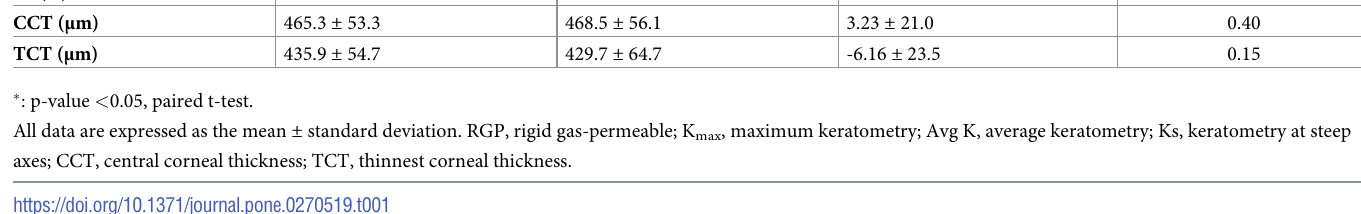
Table 2. Changes in keratoconus progression indices of the anterior and posterior corneal surface before and after the use of a rigid gas-permeable contact lens. Anterior surface Before After Change p-value Avg K (D) 55.9 ± 8.0 54.8 ± 6.5 -1.17 ± 2.14 < 0.01 � Ks (D) 58.4 ± 9.4 Posterior surface Avg K (D) -7.6 ± 1.4 Ks (D) -8.0 ±